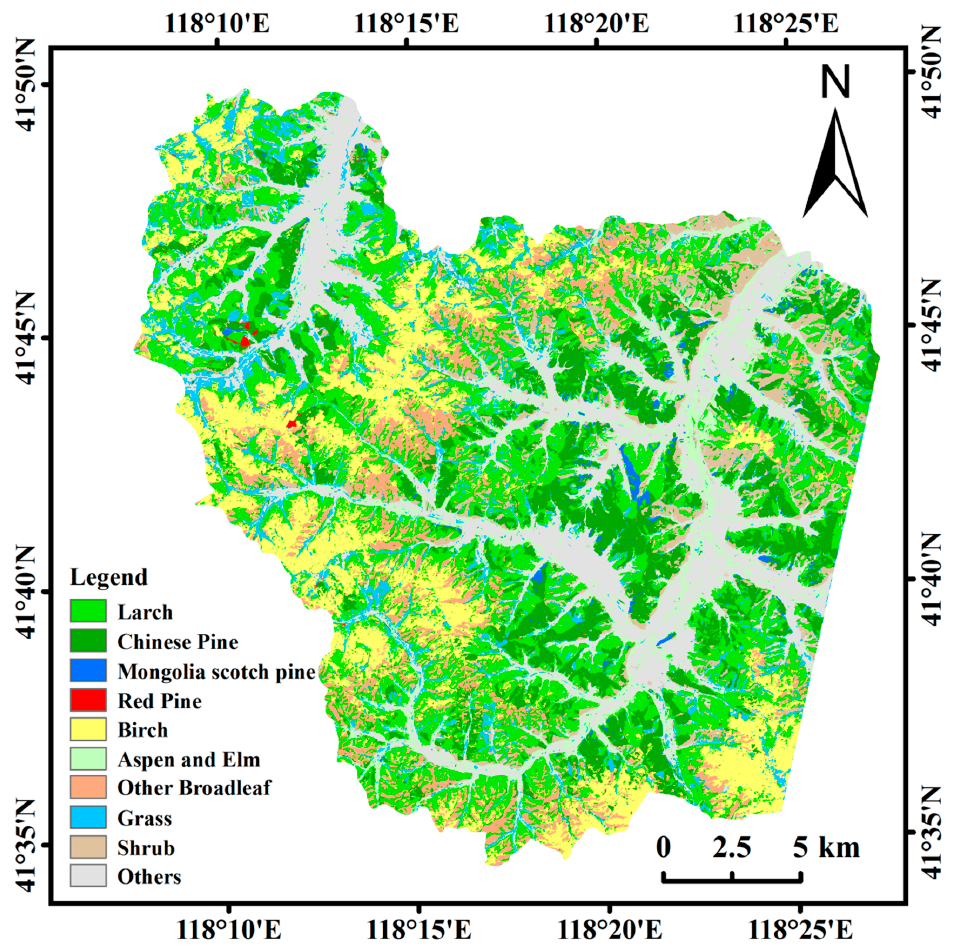
Figure 5. Land-cover classification result using a support vector machine based on spectral response, textures, and topographic factors from the combination of leaf-off and leaf-on seasons. Table 7. Area of all land-cover types in this study.